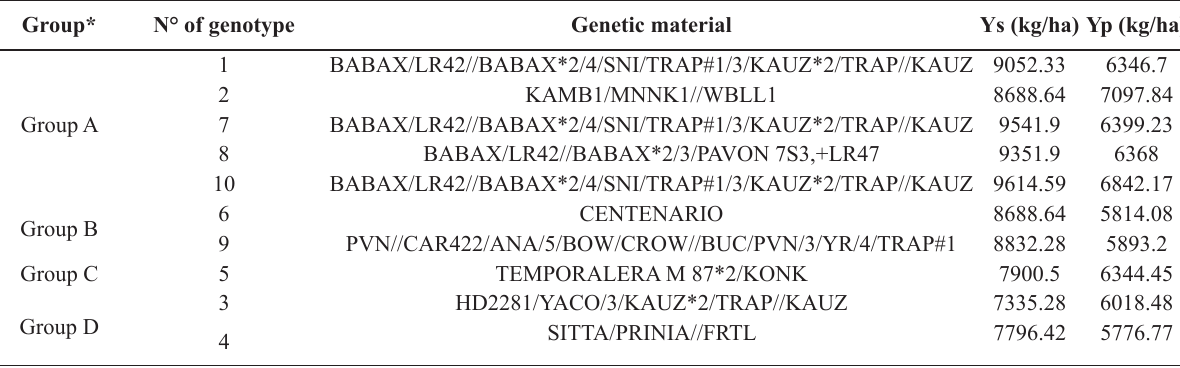
Table 11. Classification of genotypes based on their grain yield in a complete control-irrigation enviroment and in a deficit-stress-irrigation ambient of the assessment of tolerant wheat genotypes ( Triticum aestivum L.) to drought in conditions of La Molina LM 2019B.